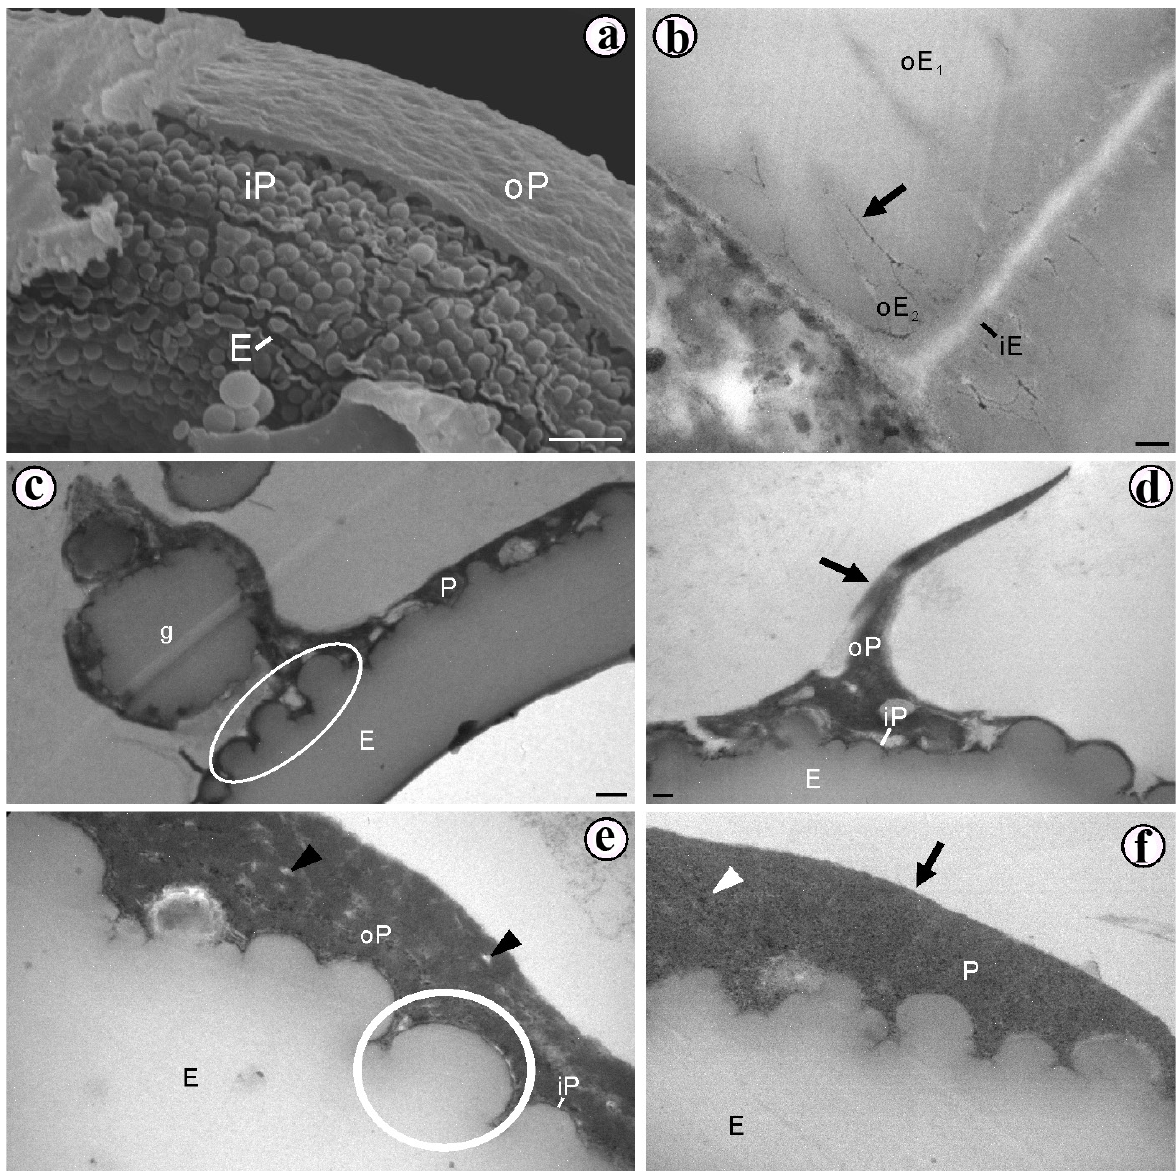
Figure 5 - Spore of Paesia glandulosa with SEM and TEM. Rugulate sculpture. a. Sporoderm fracture with SEM. The exospore is tuberculate (E). The inner perispore (iP) is thin and lining the exospore ornamentation. oP = outer perispore. Figs. b-e. Sections through the sporoderm with TEM. b. The inner exospore is homogeneous structure and low electron-density (iE). The inner stratum of the outer exospore (oE ) has ramified channels filled with an 2 electron-dense substance. The channels are connected with the channels present in outer stratum (oE ) (arrow). c. The margin of 2 exospore (E) is ornamented (ellipse). Globules are observed on the surface of perispore (g). P = Perispore. d. The outer perispore (oP) is ornamented by high and sharp ridges like crest (arrow). The inner perispore (iP) is thin and high electron-density. E = Exospore. e. The outer perispore (oP) is alveolar structure with empty cavities (arrowheads). The inner perispore (iP) is continuous, homogeneous structure and lining the ornamentation of exospore. The exospore has tubercles (circles). f. The perispore (P) is ornamented by low and rounded ridges (arrow). The cavities of alveolar substructure are filled with an electron-dense substance (arrowhead). E = Exospore. Specimen MP 4226. Scale bars: a = 2 µm; b = 0.1 µm; c = 0.5 µm; d, e and f = 0.2